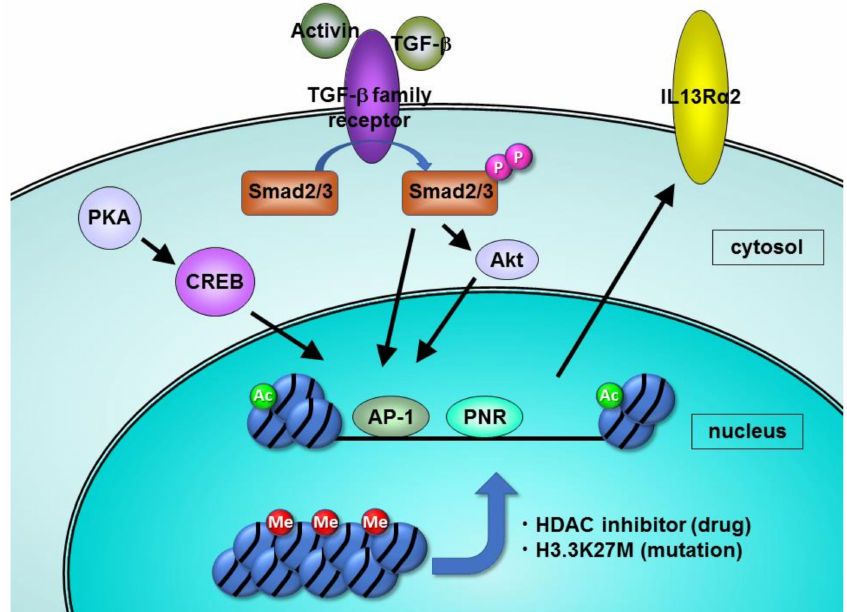
Figure 2. The schema of mechanisms increasing expression of IL-13R α 2 in cancer